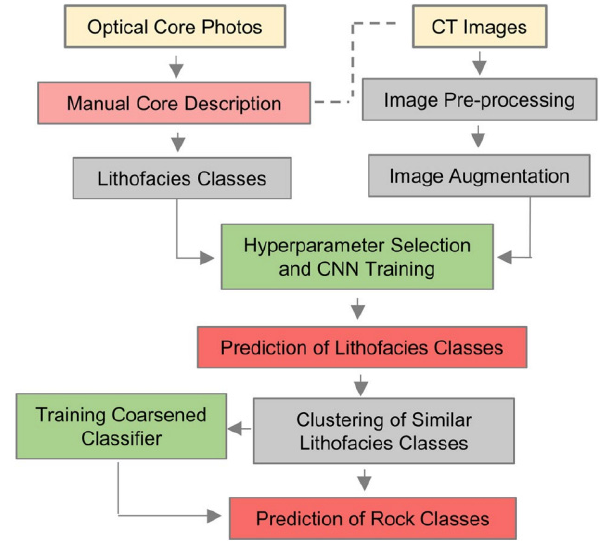
Figure 1. Proposed workflow for lithofacies classification. Reprinted with permission from [1], licensed under Creative Commons Attribution 4.0 International License. No changes were made to the original image.